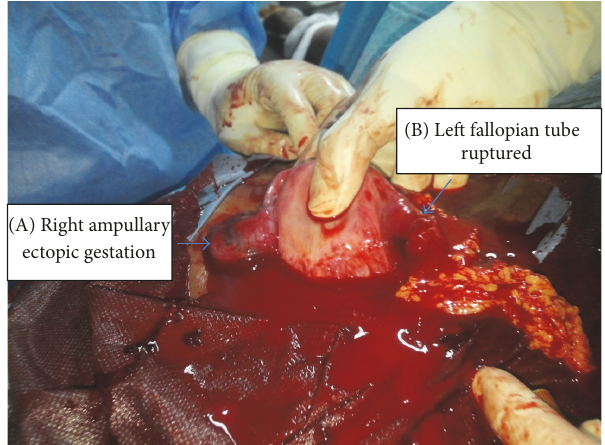
Figure 1: Peroperative view of bilateral ectopic pregnancy: (A) right ampullary unruptured pregnancy; (B) left fallopian tube ruptured with a few scraps